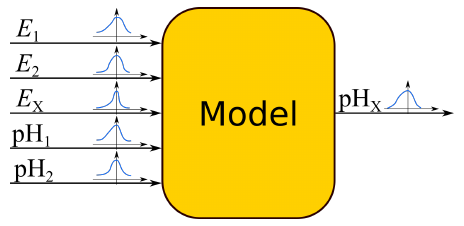
Figure 1. Concept of the Monte Carlo